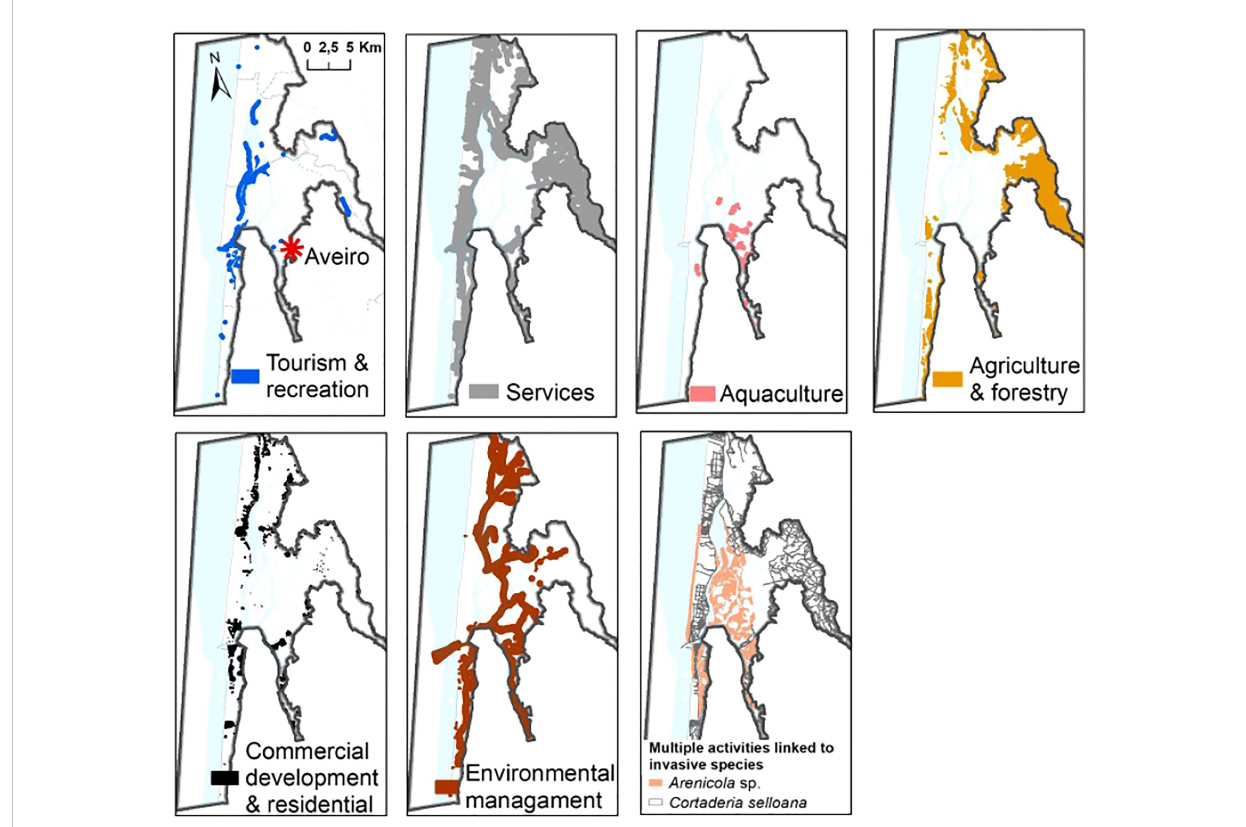
FIGURE 3 The spatial extent of consequences of the select human activities (from left to right): tourism and recreation, services, aquaculture, agriculture and forestry, commercial development and residential, environmental management. Multiple activities linked to invasive species, and affecting selected habitats are